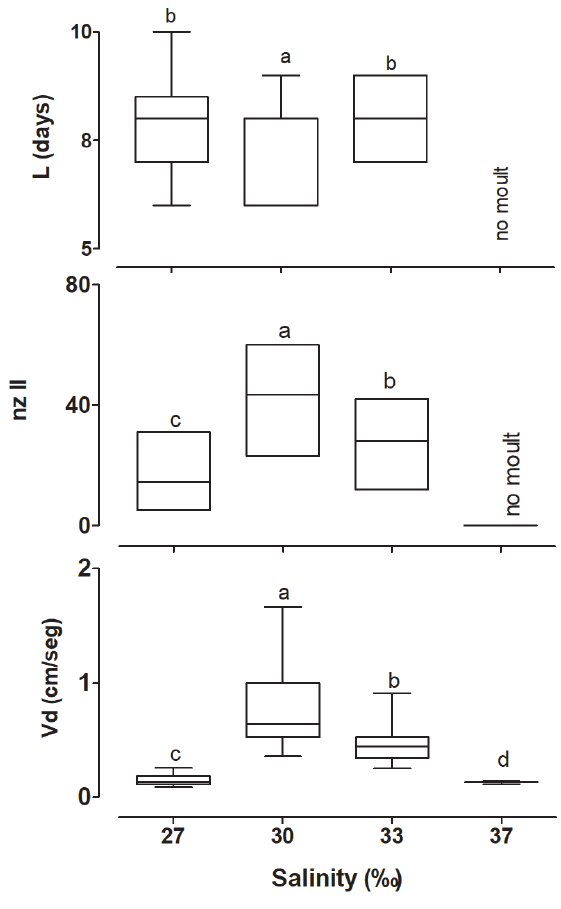
Figure 6. Length of Ovalipes trimaculatus Zoea I stage (L); speed of vertical displacements of zoeae I (cm seg-1) in response to light stimulus (Vd); number of zoeae achieving instar II relative to the number of zoeae I at the beginning of the experiments (nzII) at different salinity conditions. Different letters indicate significant statistical differences between mean L, nzII and Dv in Tuckey tests. Central mark in box plots represents the mean value; upper and lower box extremes show the inter-quartile range of observed values; whiskers show maximum and minimum observed